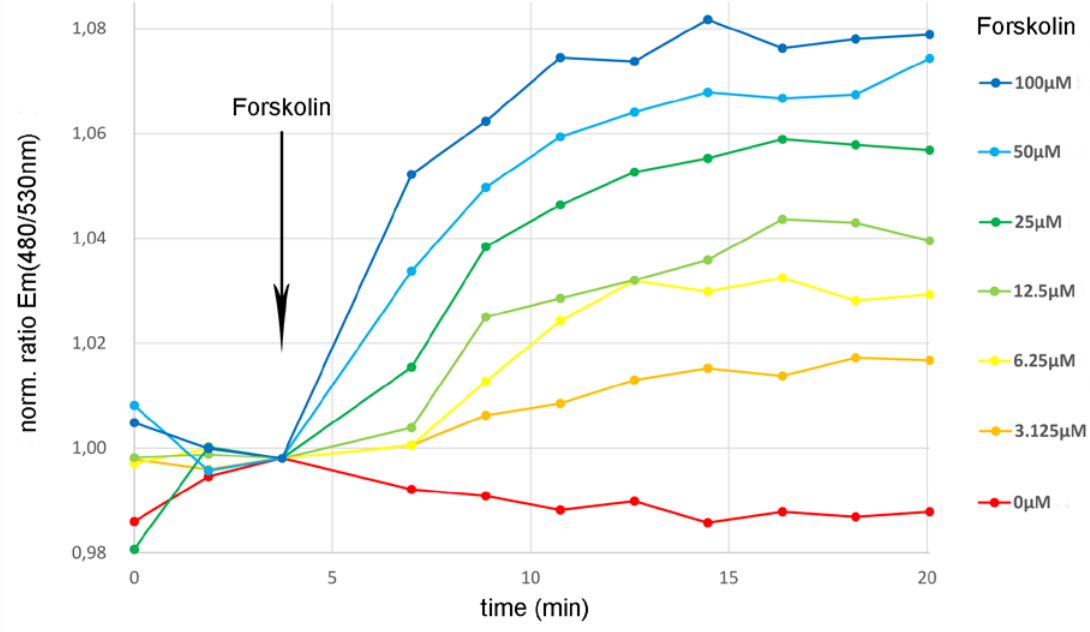
Figure 6. Forskolin-induced cAMP synthesis. The cAMP specificity of the CEPAC reporting unit of the bicarbonate sensory cellular test system is demonstrated by the activation of endogenous membrane-bound andenylate cyclase (mAC) by forskolin in a concentration-dependent manner in the range from 0 to 100 µM forskolin. Upon addition of forskolin to the assay buffer, activated mAC catalyzed cAMP synthesis leading to an intracellular increase in cAMP concentration. This resulted in an increase in the fluorescence emission ratio of the cAMP reporter CEPAC in the bicarbonate sensor cell. This increase in the fluorescence emission ratio elicited through the activation of mAC by forskolin was similar to the fluorescence emission ratio increase elicited through the activation of sAC tr by bicarbonate (Figure 3). Data are expressed as mean (n = 6).